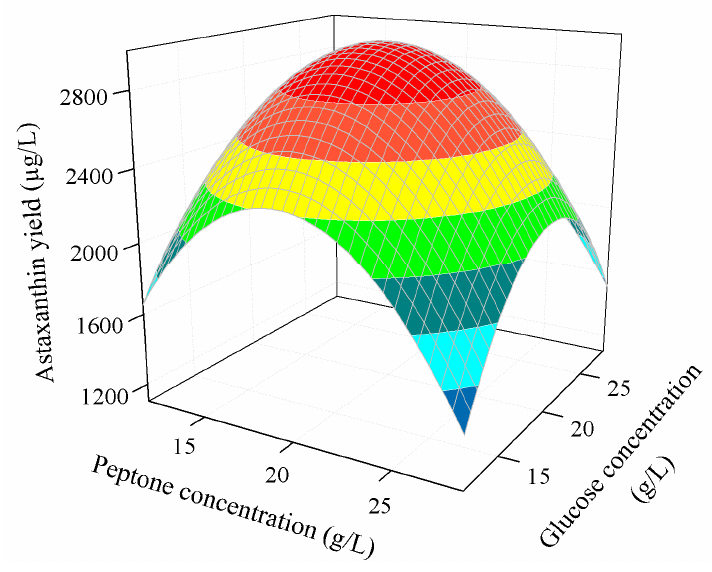
Figure 4. Combined e ff ect of peptone concentration and glucose concentration on astaxanthin production by R. toruloides mutant.